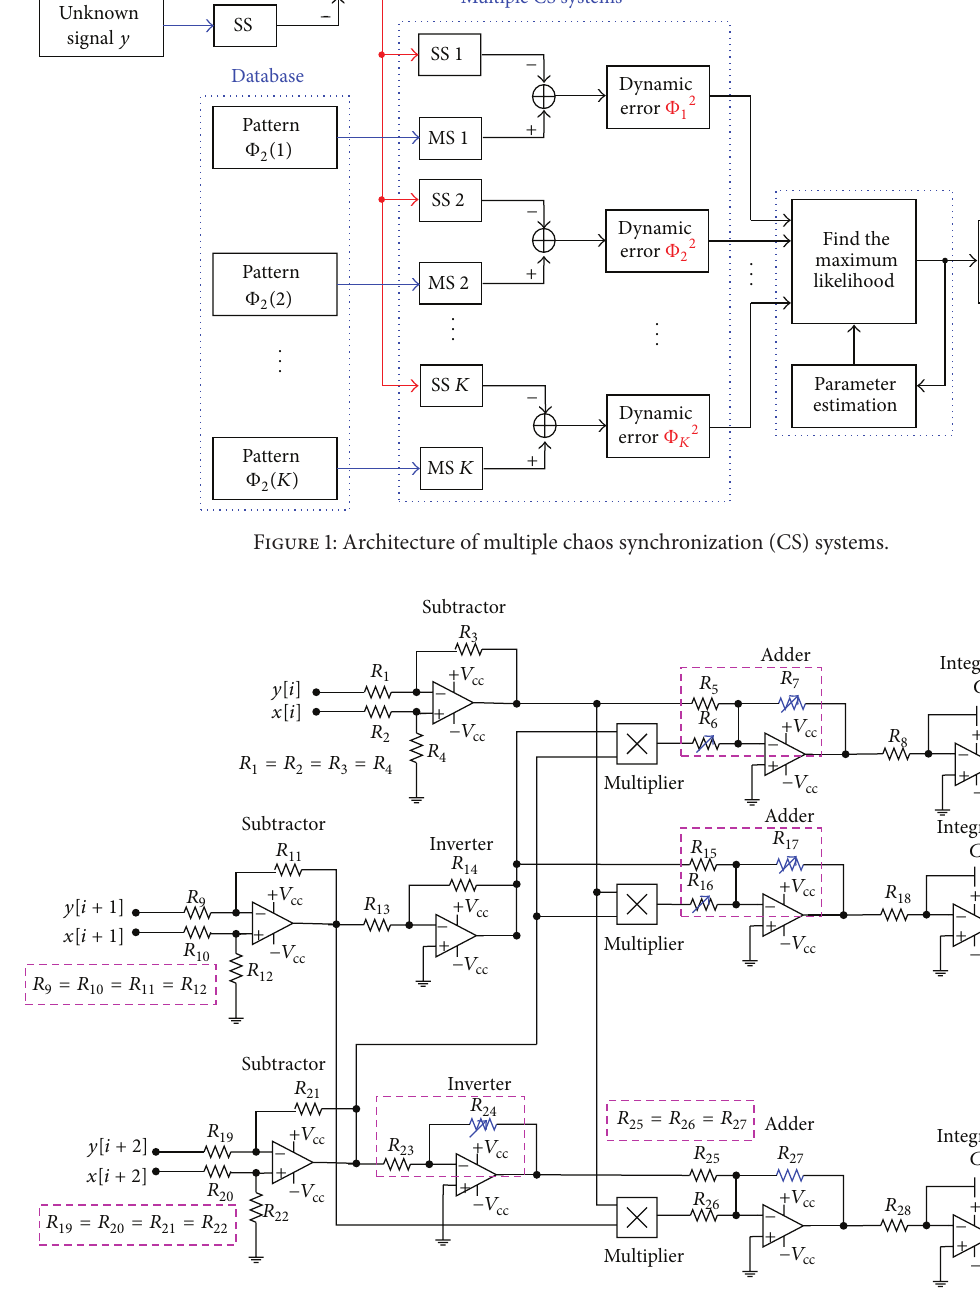
Figure 2: The nonlinear electronic circuits of Chen-Lee based CS